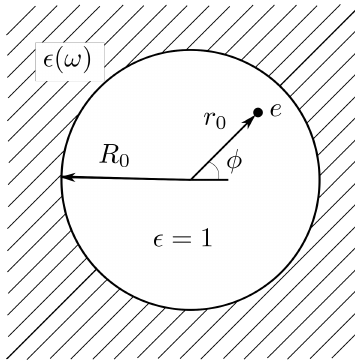
Figure 8. Scheme of a cylindric cavity of radius R 0 in the infinite dielectric, characterised by the permittivity (cid:101) ( ω ) , with a particle of the charge e moving inside the cavity. For the cavity, we choose (cid:101) =